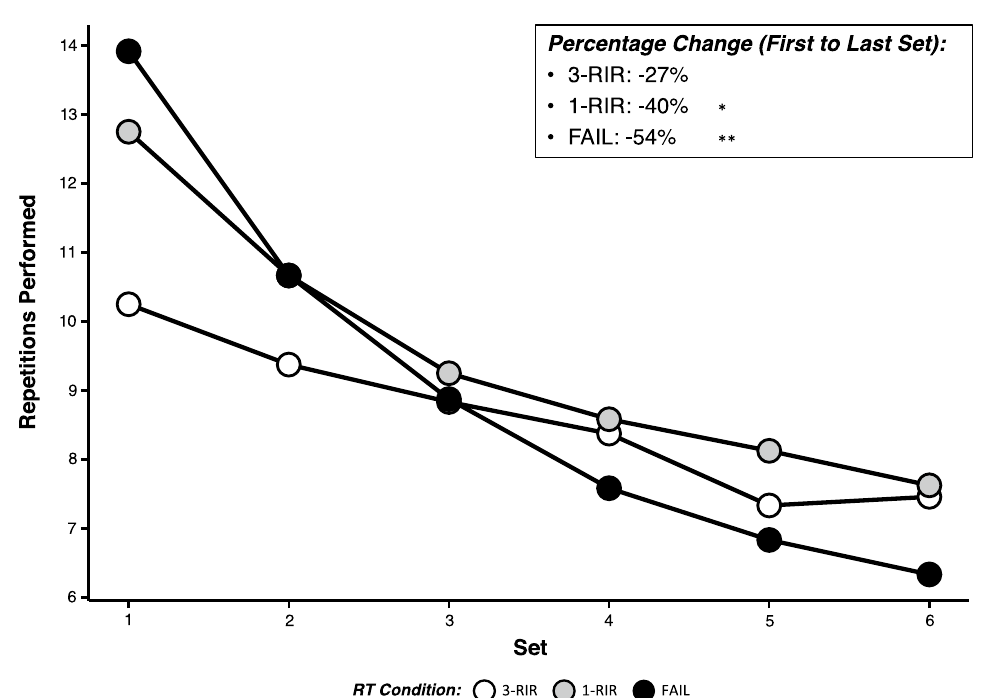
Fig. 6 Number of repetitions performed in each set. Data shown are presented as mean (absolute) values (accompanying SD values can be found in Additional file 1: S4). *Denotes a statistically significant difference from 3-RIR. **Denotes a statistically significant difference from 1-RIR and